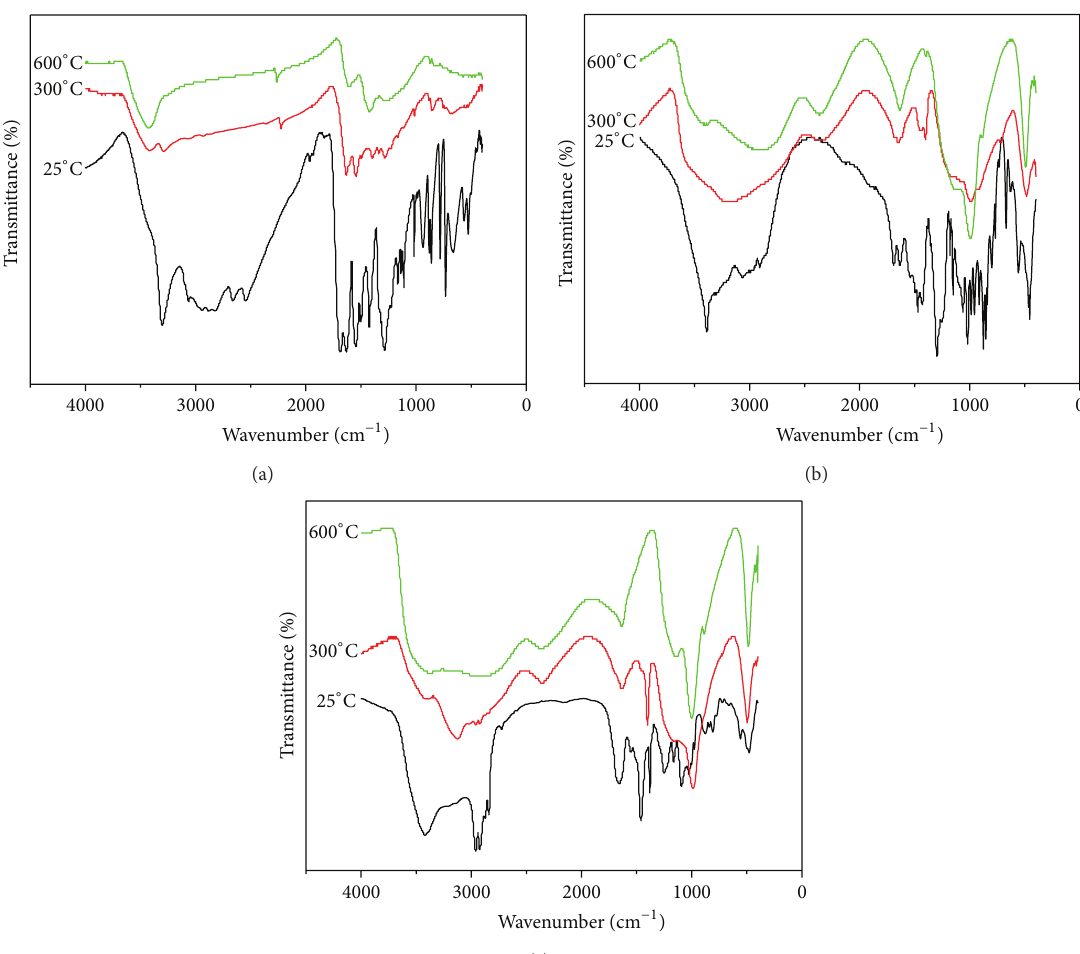
Figure 7: FTIR spectra at different pyrolysis temperatures of PETA (a), IFR/PETA (b), and PP/IFR/PETA